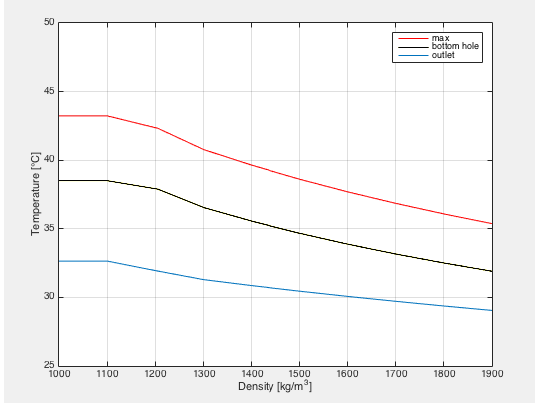
Figure 17: Temperature vs. Density